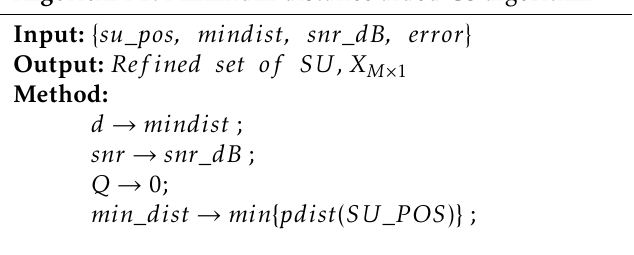
Algorithm 1: Minimum distance aided CS algorithm